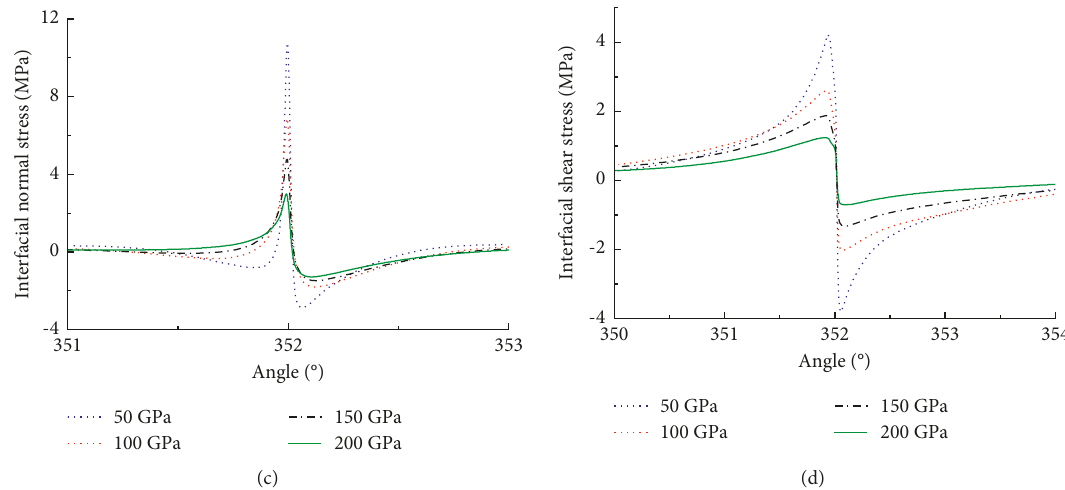
Figure 14: Interfacial stresses under steel plates with different elastic modules. (a) Normal stress near plate end. (b) Shear stress near plate end. (c) Normal stress near 352 ° joint. (d) Shear stress near 352 ° joint.